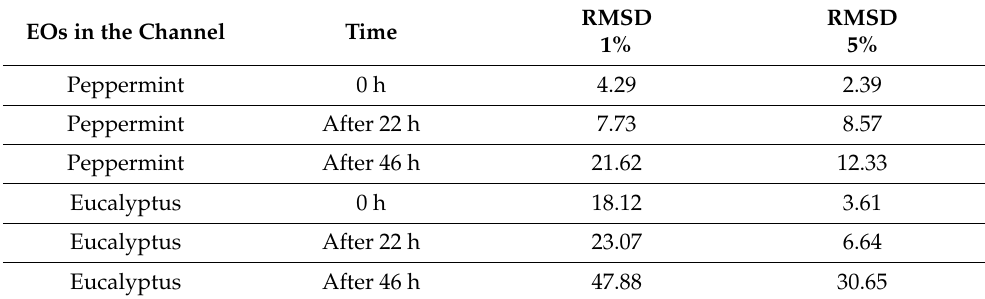
Table 3. Calculated RMSD values for EO types and concentrations at different exposure times. EOs in the Channel Time Peppermint